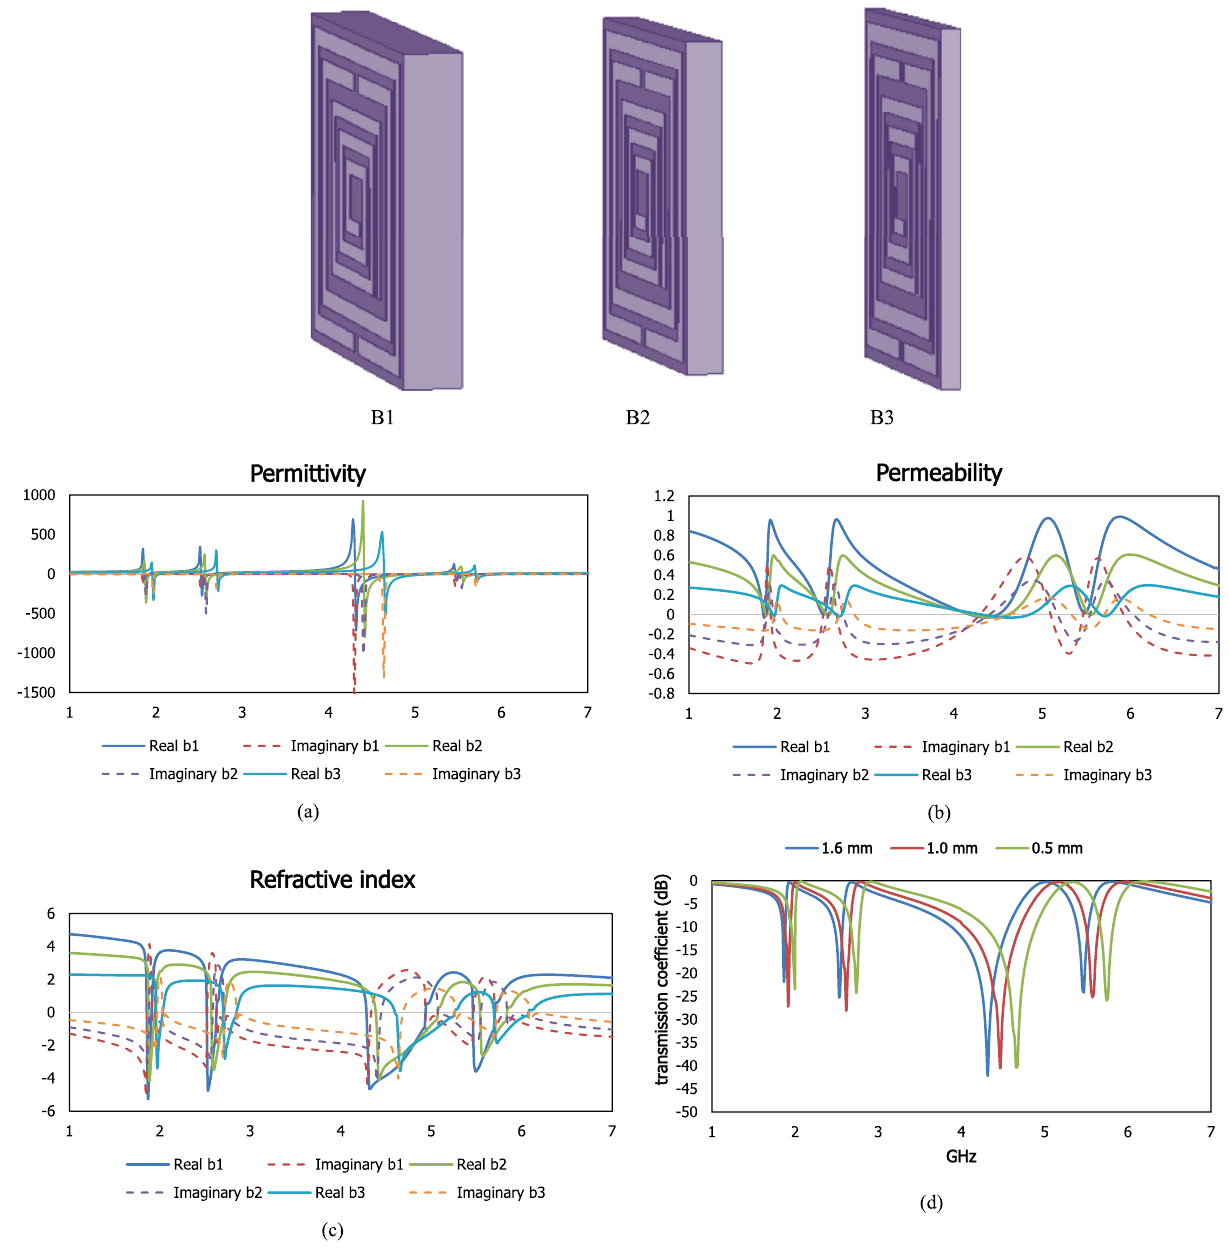
Figure 13. Relative permittivity ( a ), relative permeability ( b ) and refractive index ( c ) and transmission coefficient ( d ) for different